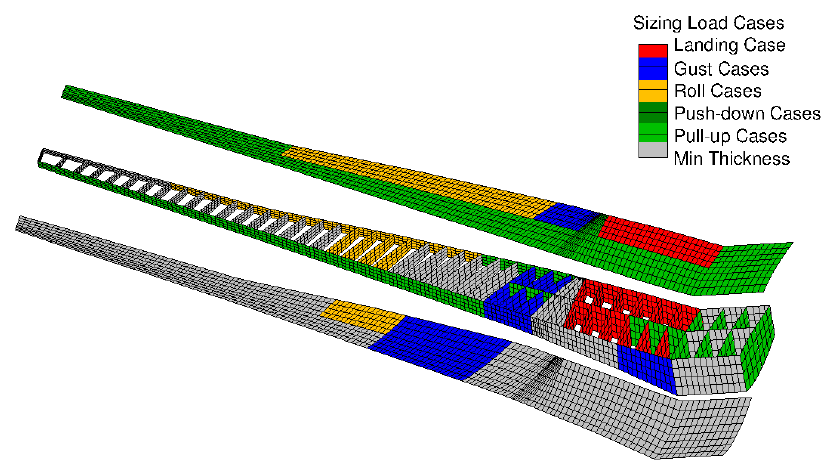
Figure 37. Sizing load cases for each design field—red. load factor.